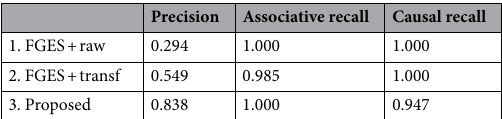
Table 3. Metrics from clinical evidence.